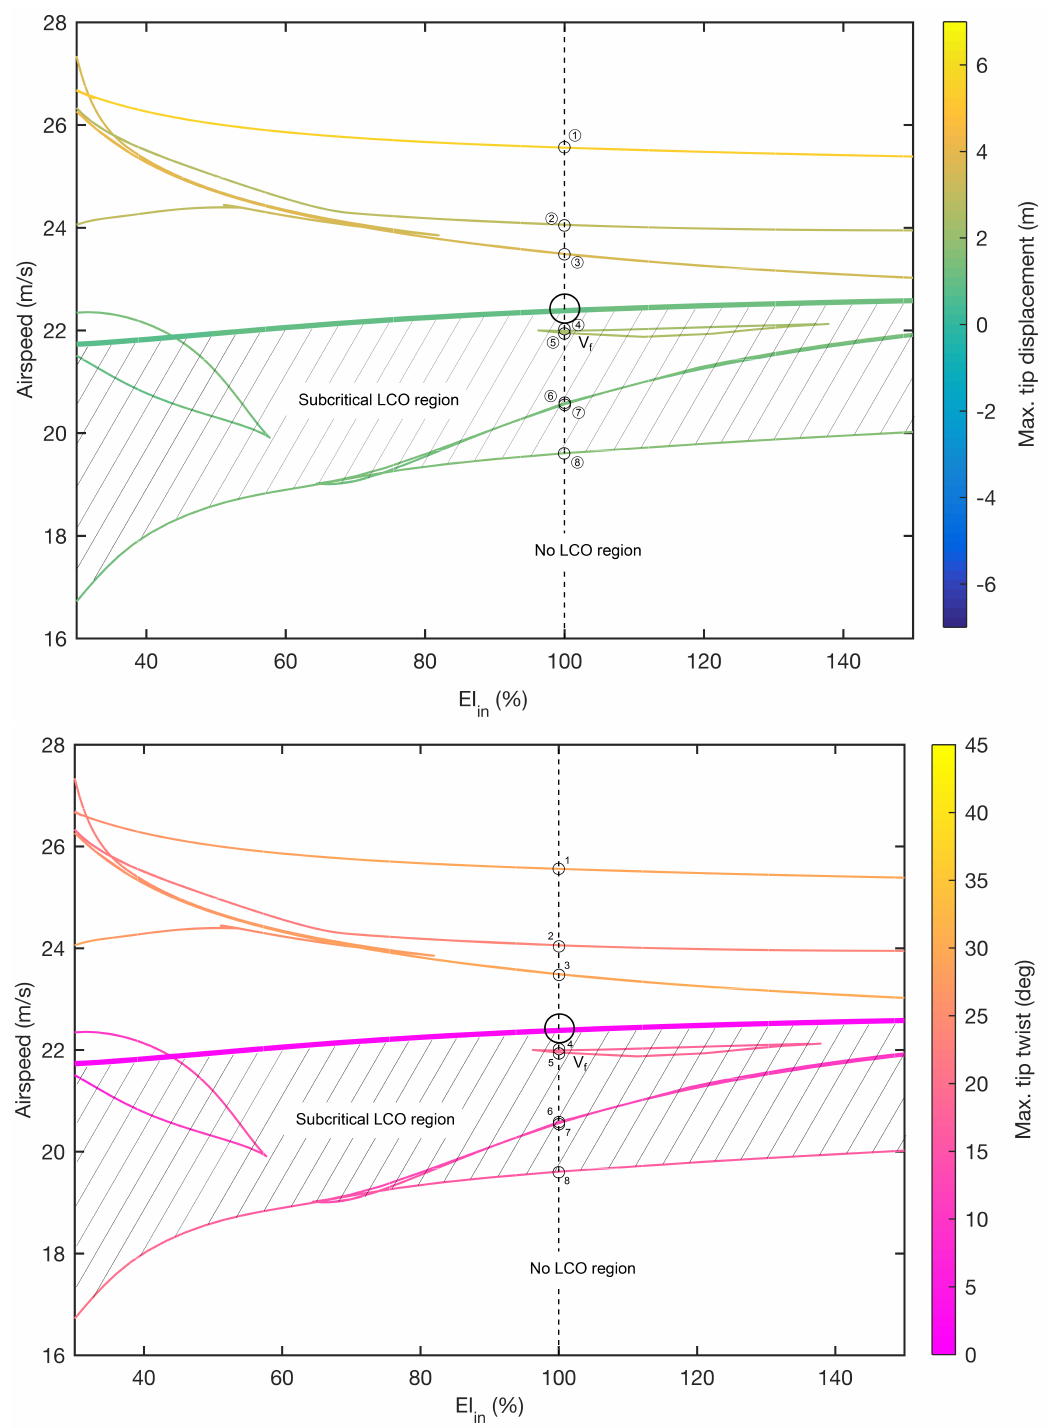
Figure 13. Two-parameter continuation of Hopf points and periodic folds for varying in-plane stiffness and airspeed. The shaded region indicates where subcritical LCOs exist in the